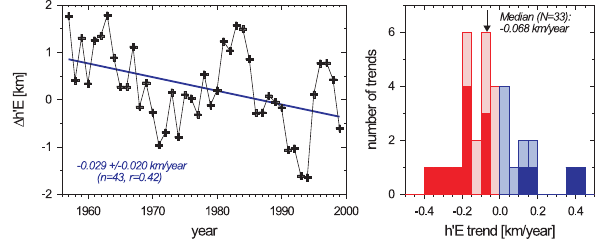
Fig. 5. Global mean foE trend (left part) and histogram (right part) deduced from observations at 71 individual ionosonde stations.